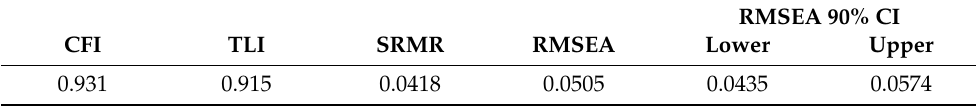
Table 4. CFA fit